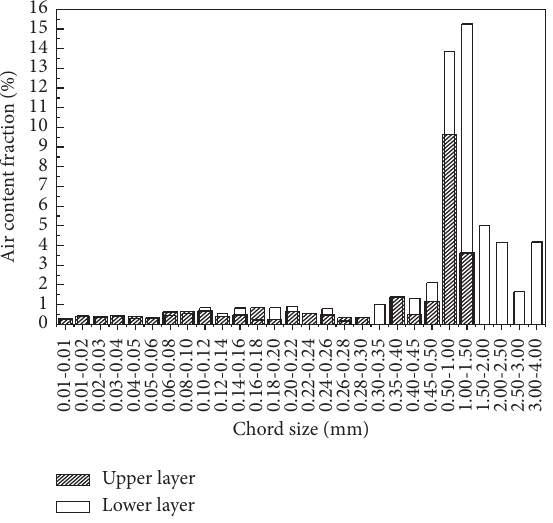
Figure 3: Chord size distribution of the